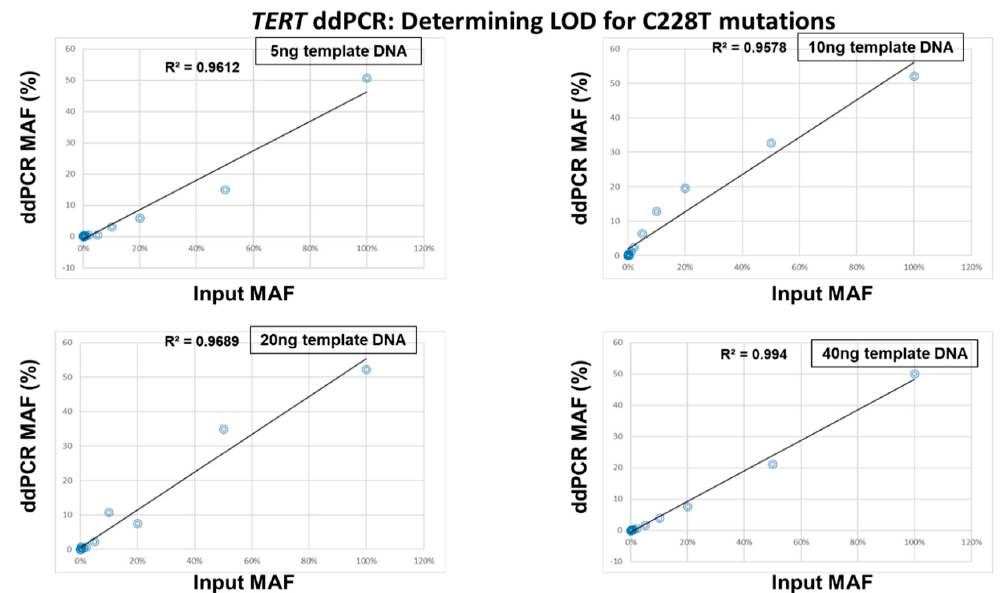
Figure 3. Linearity between the input Mutant Allelic Fractions (MAFs) and the experimentally determined MAFs for the TERT C228T assay. The theoretical percentage of MAFs from serially diluted C228T mutated template DNA into wild-type DNA was plotted against the experimentally determined ddPCR MAFs for 5 ng, 10 ng, 20 ng and 40 ng.